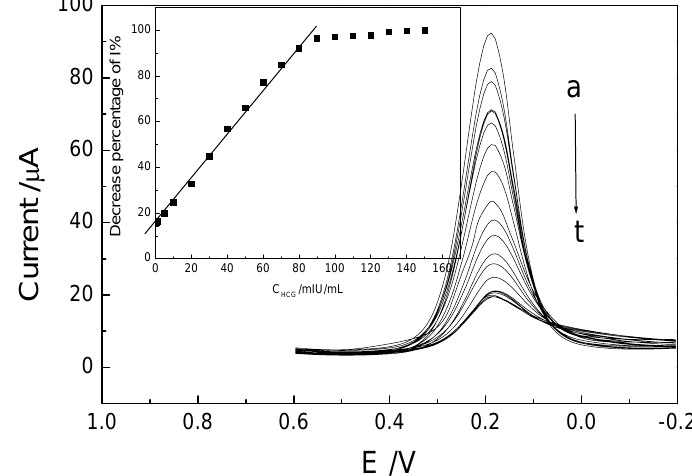
Figure 6. DPVs of the the immunosensor incubated in p24 solution with different concentrations of a~t: 0, 0.1, 0.5, 1, 5, 10, 20, 30, 40, 50, 60, 70, 80, 90, 100, 110, 120, %~C 130, 140, 150 ng/mL; the insert : Δ I/I H